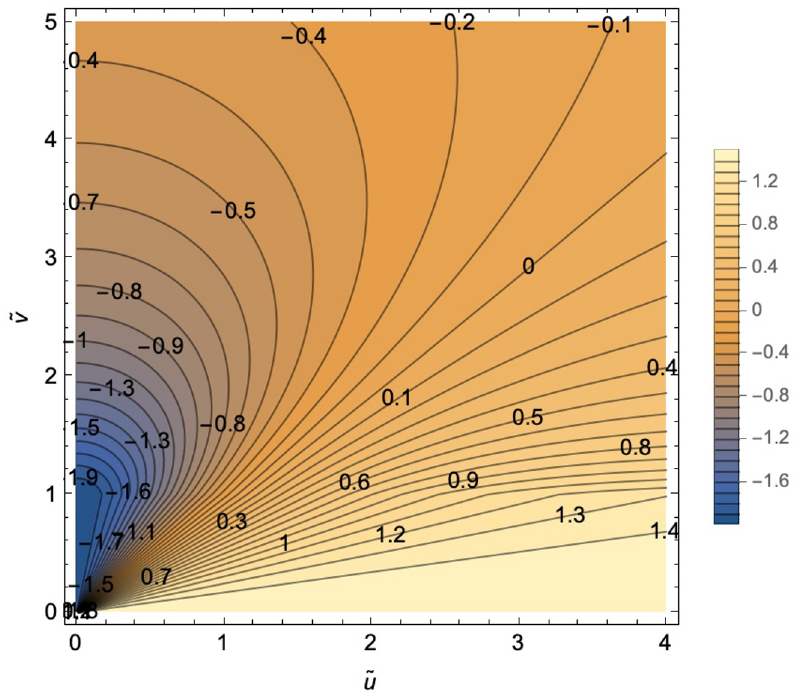
Figure 2 . A contour plot of the function H 1 from equation